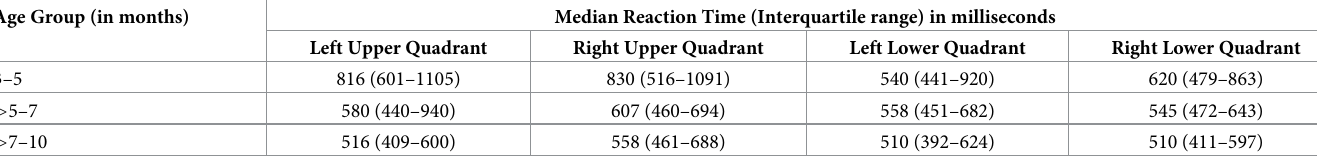
Table 3. Median reaction time to all 4 quadrants for all the age group. Age Group (in